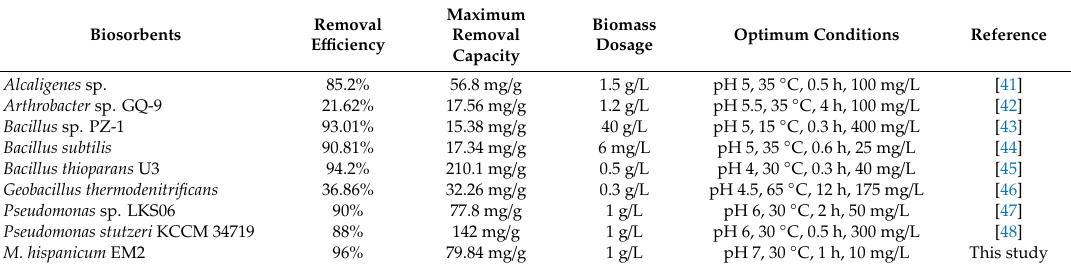
Figure 3. Time-dependent Pb(II) adsorption efficiency under optimum conditions. The experimental conditions were as follow: biomass = 1 g/L, initial Pb(II) concentration = 10 mg/L, and pH 7. The values and error bars represent the means ± standard deviation ( n = 3). Table 2. Comparative analysis of biosorbents for Pb(II) removal.